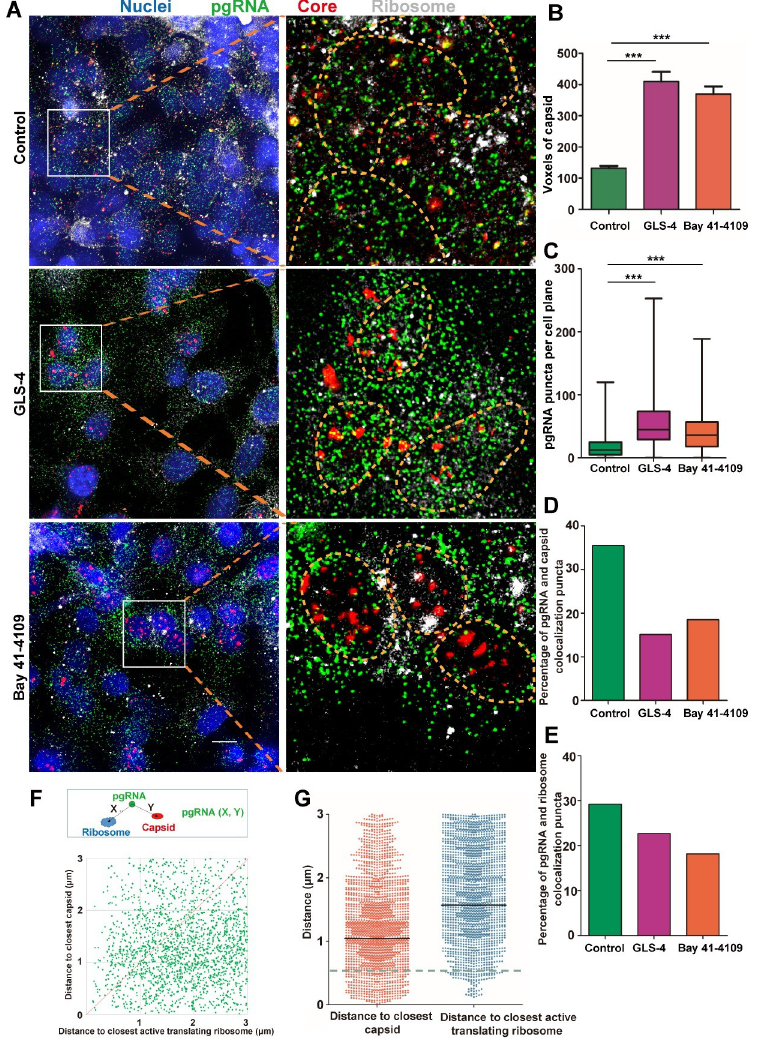
Fig 4. Colocalization of HBV pgRNA with active translating ribosomes or capsid in HepAD38 (DOX) cell. (A) HepAD38 (DOX-) cells were untreated or pretreated with 10 μ M GLS4/Bay 41–4109 followed by puromycin (Puro) labeling. Cells were fixed and processed for pgRNA detection followed by immunofluorescence staining for puromycylated ribosomes with Alexa Fluor 488 labelled secondary goat anti-mouse antibody and capsid with Cy3 labelled secondary goat anti-rabbit antibody. Nuclei borders were represented by yellow dashed lines in the enlarged areas. Scale bar, 4 μ m. (B) Voxels of capsid were quantified using Huygens. (C) Puncta of pgRNA were quantified using FISH-quant. More than 200 cells per group were counted. (D, E) Percentage of pgRNA colocalized with capsid or puromycylated ribosomes were quantified by Huygens. (F) Distance between pgRNA and capsid (Y) or puromycylated ribosomes (X) were shown as a two-dimensional plot. (G) The distribution of aforementioned X and Y values were shown as a scatter plot with marked mediums. A dashed line of 0.5 μ m, the threshold for defining colocalization, was shown. ��� P < 0.001 (Mann-Whitney